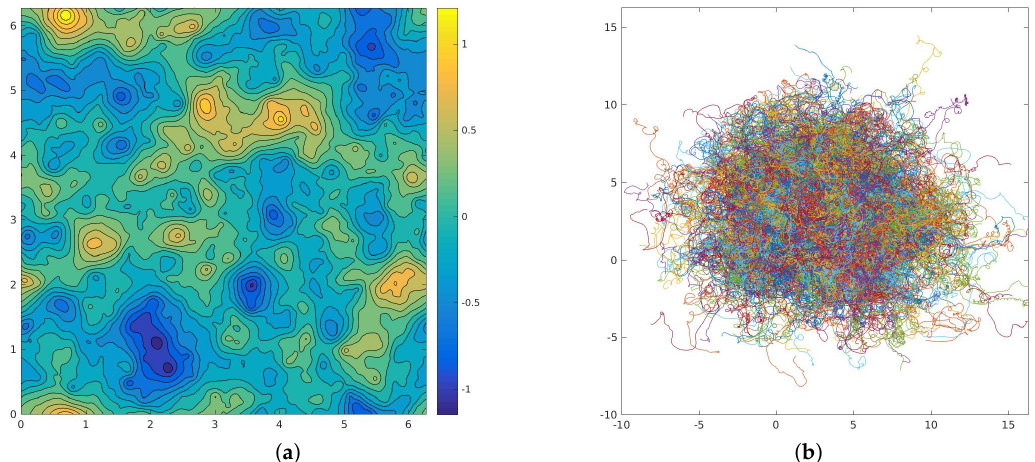
Figure 4. Streamfunction ( a ) and particle trajectories ( b ) from a two-dimensional turbulence simulation forced in the range K = [ 30,35 ] . The trajectories have been “unwrapped” from the doubly periodic domain, which explains why their extent exceeds the domain scale of 2 π